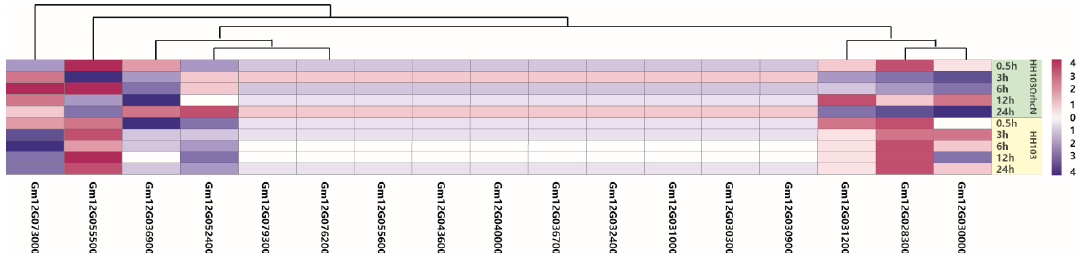
Figure 3. Heat map diagrams of relative expression levels of candidate genes inoculation with Ensifer fredii HH103 and Ensifer fredii HH103 Ω rhcN, 0.5, 3, 6, 12, and 24 h post inoculation. Heatmap was plotted using heatmap.2 function of the R/Bioconductor package gplots. Hierarchical clustering of the DEGs was done by complete method with Euclidean distance. The gene expression levels were transformed by log2 (FPKM + 1) and the values were centered and scaled in row direction. X-axis, differentially expressed gene names; Y-axis, samples. Purple and blue colors indicate a relative increase or decrease in expression inoculation with Ensifer fredii HH103 and Ensifer fredii HH103 Ω rhcN. Seven genes ( Glyma.12g028300 , Glyma.12g030000 , Glyma.12g036900, Glyma.12g052400 , Glyma.12g055500, Glyma.12g031200 and Glyma.12g073000 ) had different expression patterns inoculation with Ensifer fredii HH103 comparison with Ensifer fredii HH103 Ω rhcN mutant.